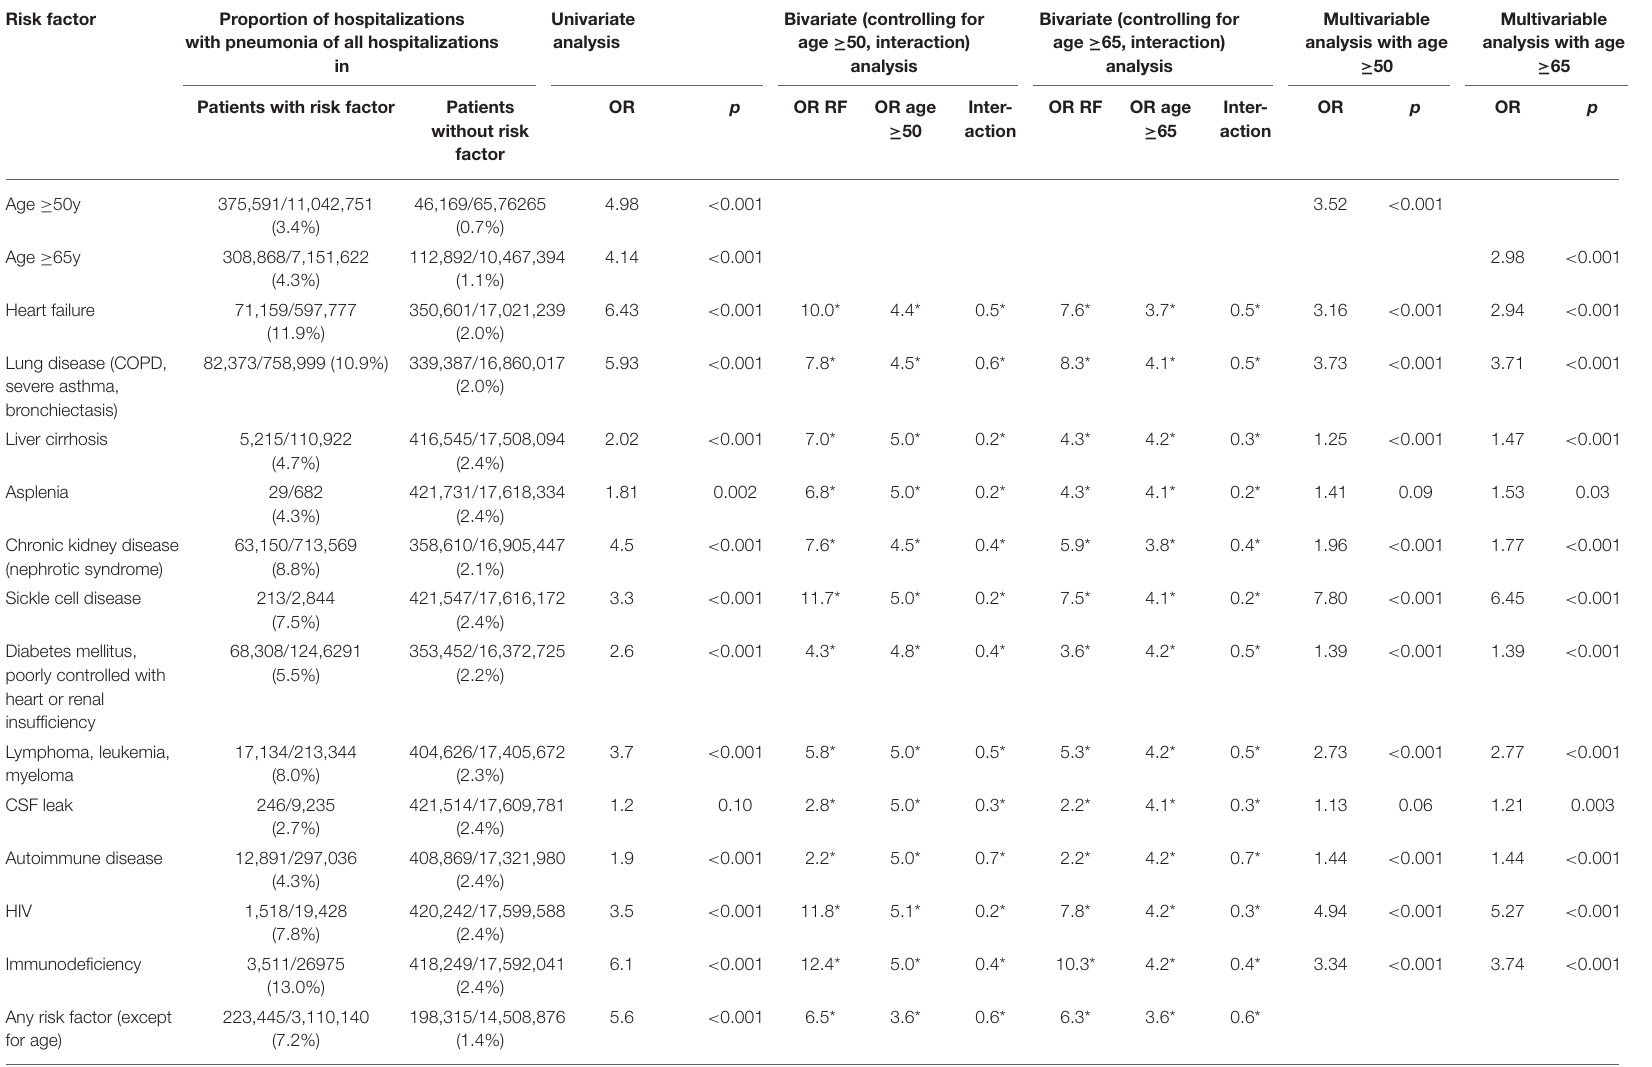
TABLE 1A | Hospitalizations with pneumonia in persons with and without risk factors. Univariate Bivariate (controlling for Risk factor Proportion of hospitalizations analysis age ≥ 50, with pneumonia of all hospitalizations in